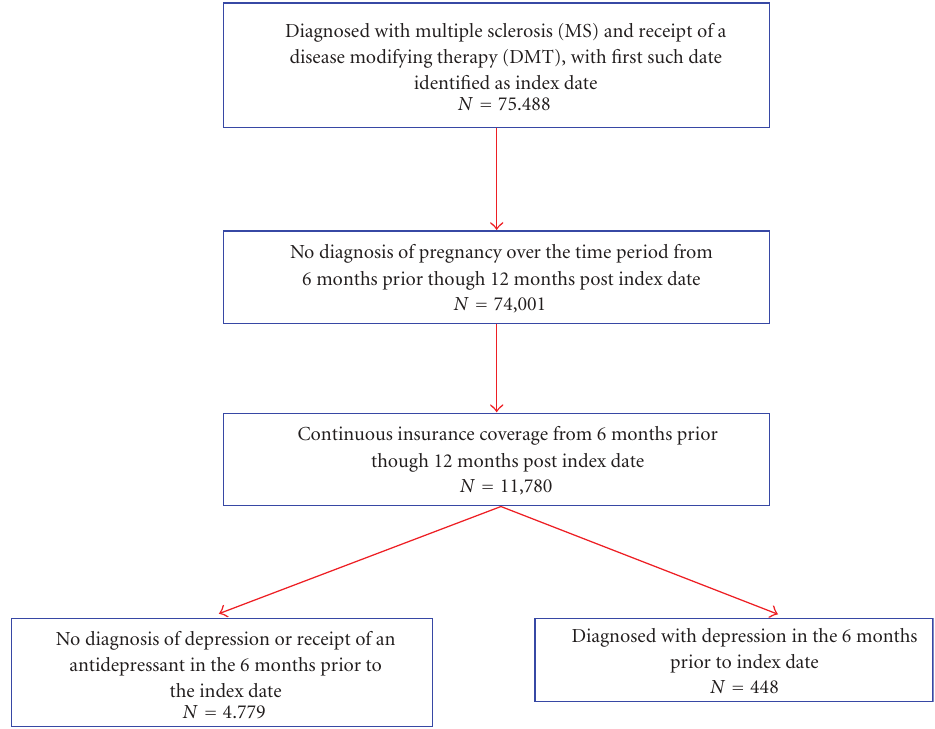
Figure 1: Inclusion/exclusion